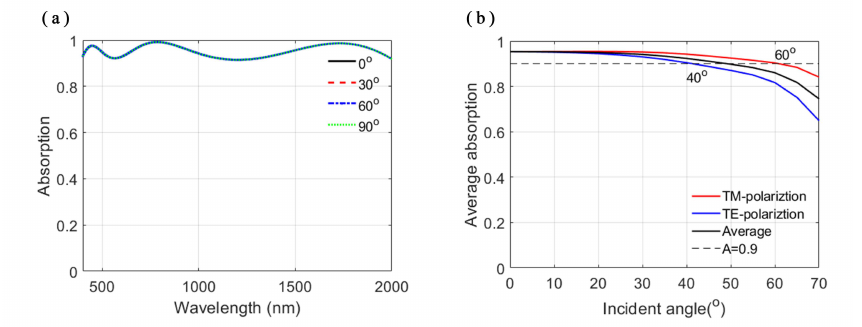
Figure 8. ( a ) Absorption spectra of the SiO 2 /patterned-TiN/SiO 2 /TiN stacks with respect to the varying polarization angle between the polarization direction and x -direction under normal incidence. ( b ) Average absorbance plot of the SiO 2 /patterned-TiN/SiO 2 /TiN stacks with respect to the varying incident angle for TM, TE and unpolarized